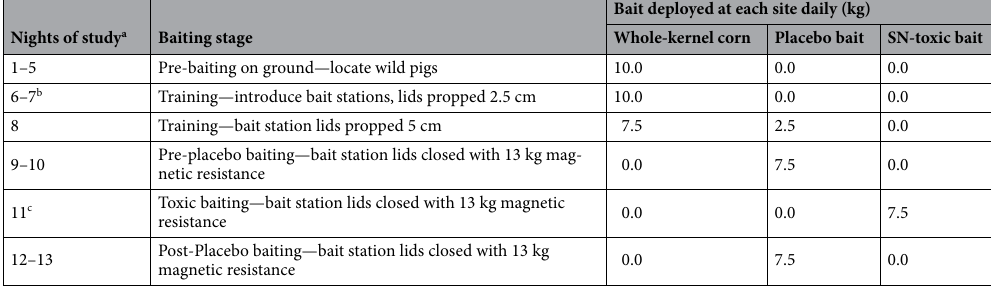
Table 2. Baiting strategy to locate, pre-bait, and train wild pigs to use bait stations and consume SN-toxic bait used in north-central Texas, USA during July 2020. a Adjusted ± 2 nights at any stage if wild pigs did not visit during certain nights, needed a longer training period because they did not access, or readily accessed and could advance more quickly. Our goal was to advance through each baiting stage as quickly as possible with the balance of allowing the majority of wild pigs access bait inside of the bait stations at each stage, determined by daily examination of remote camera images. b Bait stations were placed 10–30 m from pre-baiting sites to avoid any particles of whole-kernel corn left on the ground in an effort to reduce non-target visitation. c At 5 of 10 bait sites with the deterrent devices, the devices were activated at 0520 h (i.e., 1 h before first-light) the morning following toxic bait deployment. Deterrent devices were deactivated upon arrival of operators to